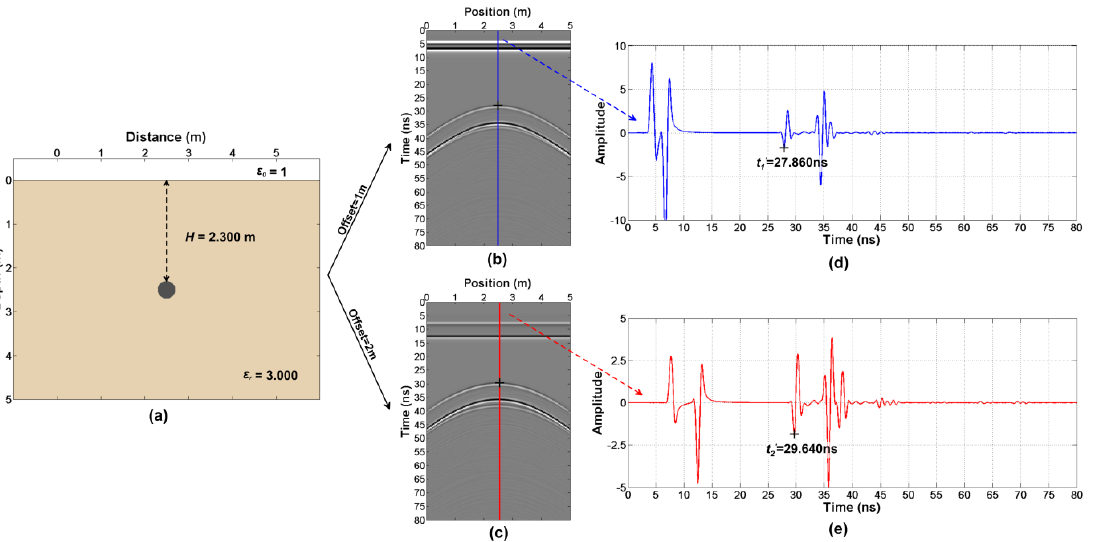
Figure 3. The first case (transmitter and receiver are close to the ground): ( a ) The model; ( b ) The forward result with an offset of 1 m; ( c ) Forward result with an offset of 2 m; ( d , e ) The single traces, as shown in the figure. Table 1. Simulation Parameters.